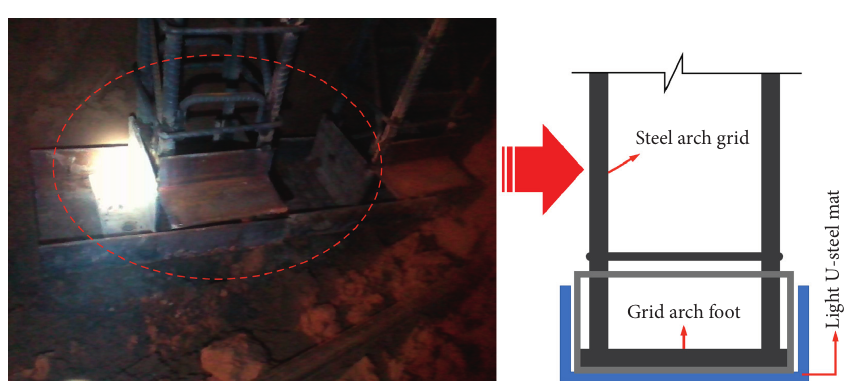
Figure 12: The setting of light U -steel mat under the bottom of the steel arch.